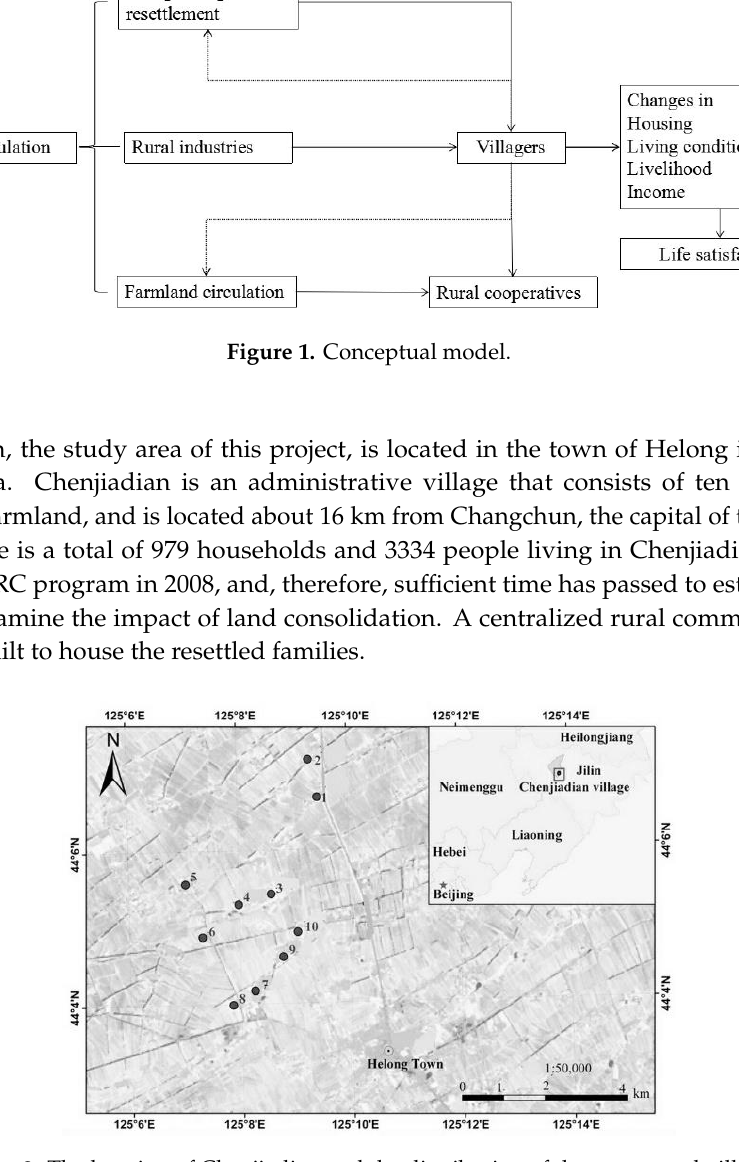
Figure 2. The location of Chenjiadian and the distribution of the ten natural villages.